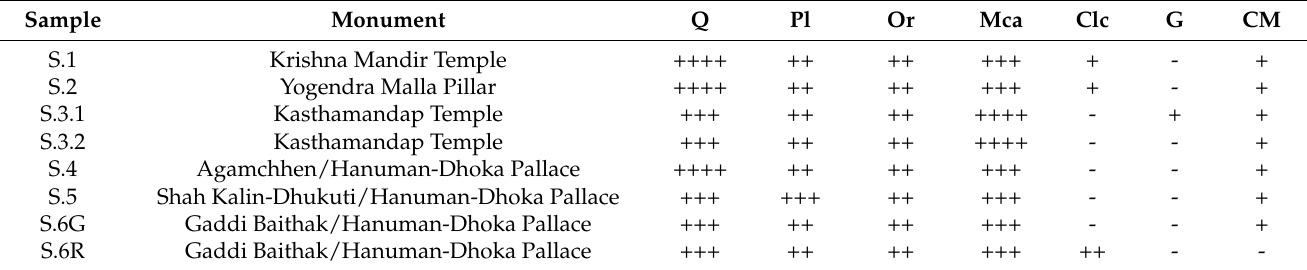
Table 2. Semi-quantitative results of the bulk mineralogical composition of the mortar samples assessed by